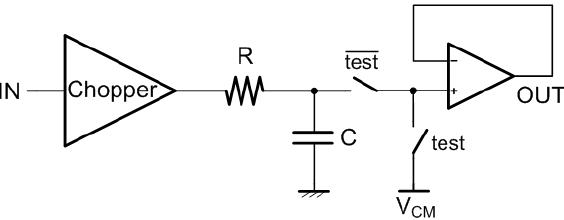
Figure 4. Proposed test-chip prototype architecture.